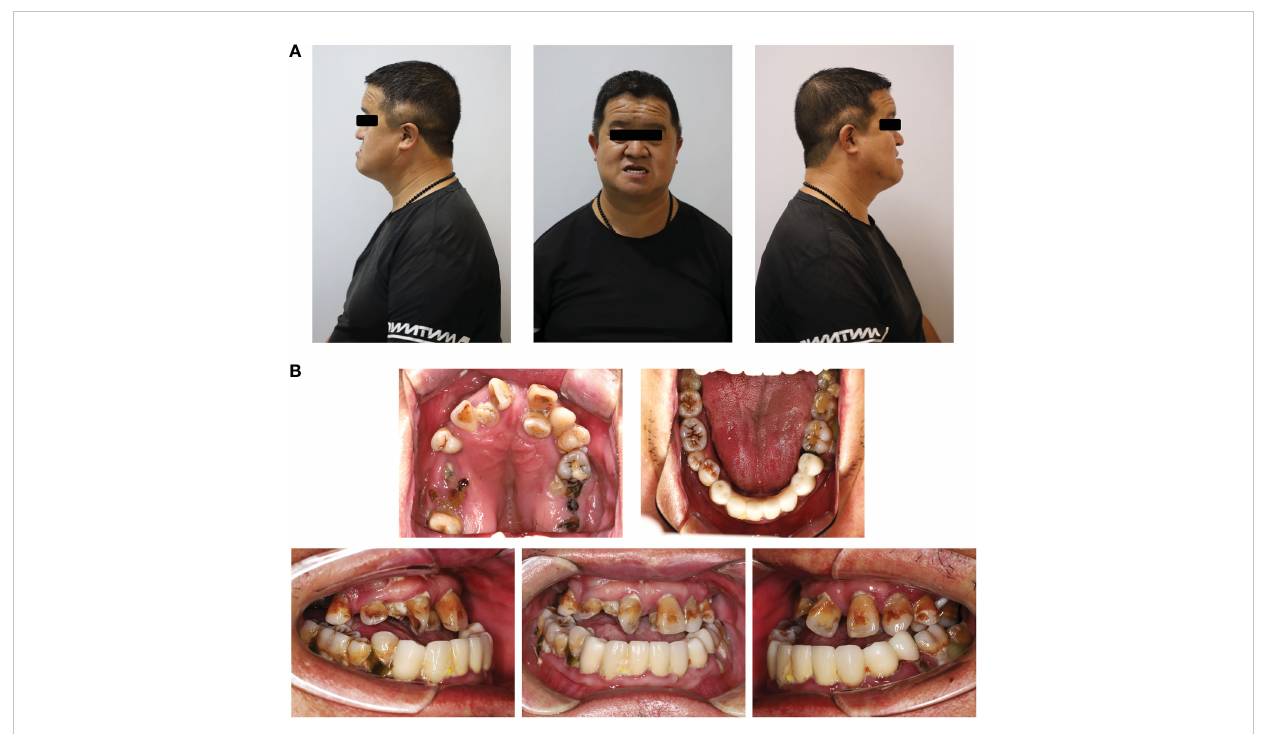
FIGURE 2 Typical clinical and radiological fi ndings in the father of the proband. (A) Front and pro fi le photograph of the individual showing a concave face, hypoplasia of the maxilla, and a depressed nasal bridge. (B) Intraoral image showing enamel and dentin hypoplasia and the lower anterior teeth missing.